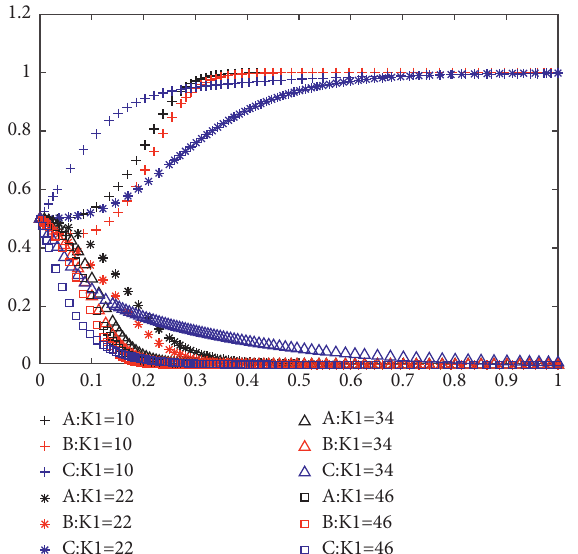
Figure 7: Evolutionary analysis of the cost changes of financial institutions participating in the cooperation of technology-based SMEs.